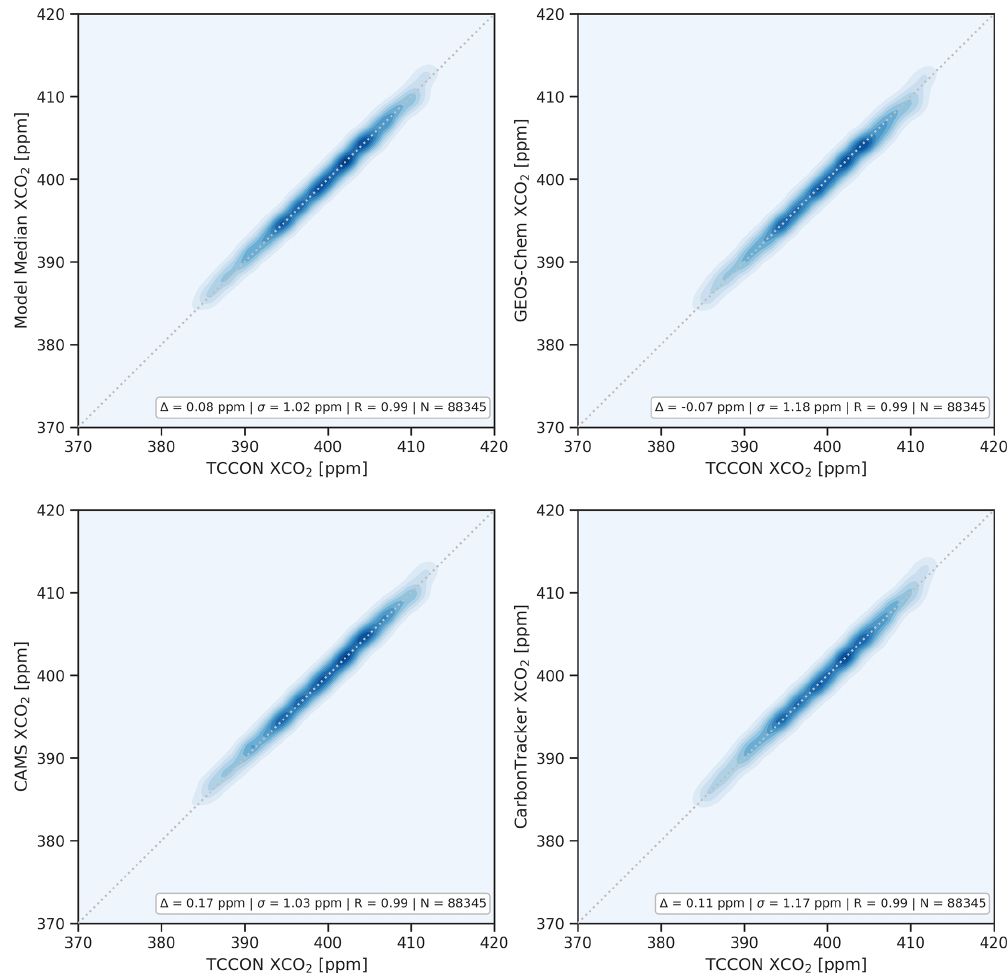
Figure 9. Correlation of the individual XCO 2 models (GEOS-Chem, MACC and Carbon-Tracker) used in the generation of the GOSAT Proxy XCH 4 data against matching co-located TCCON XCO 2 measurements. The first panel shows the median model value which is the quantity directly used in Eq. (1) to generate the final Proxy XCH 4 quantities. The data are presented as a two-dimensional kernel density estimation (KDE) plot with the one-to-one line shown as the grey dashed line. Also included are the statistics (difference, standard deviation, correlation coefficient and number of matching measurements) comparing each model to the TCCON XCO 2